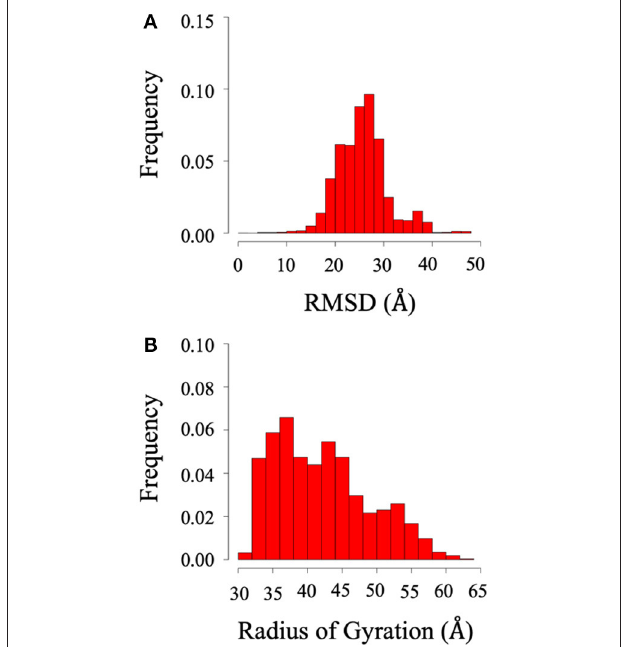
FIGURE 2 | RMSD and radius of gyration of System 1 (BAR domain with PDZ domain and linker). (A) RMSD. (B) Radius of gyration. The wide range of frequency signifies the system is very dynamic.